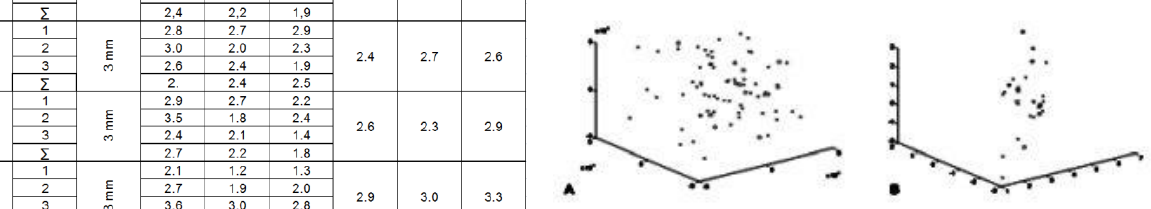
Figure 8: Distribution of the control and check points detected in a) orthoimages and b) spherical